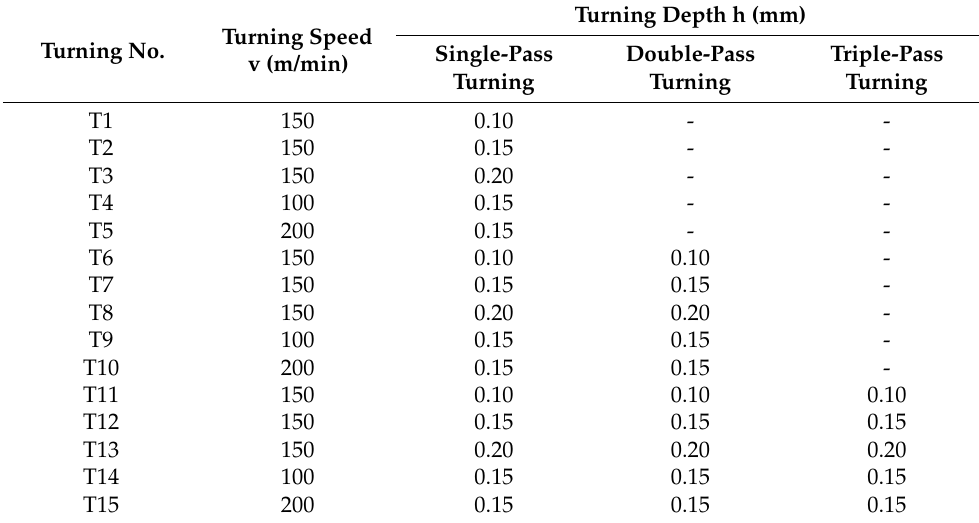
Table 2. Turning parameters for specimen preparation.